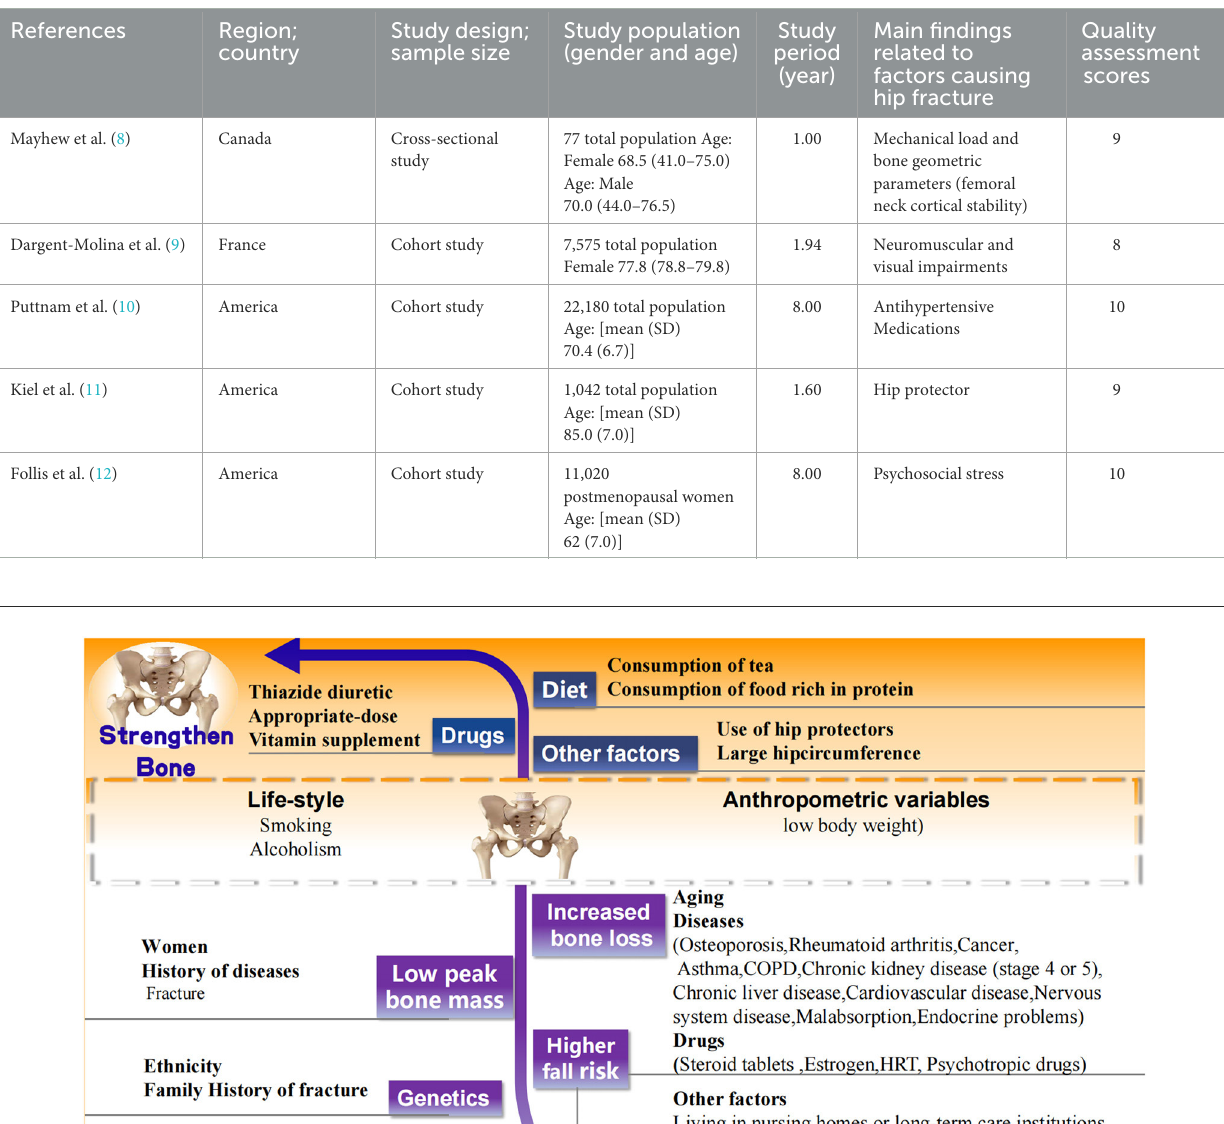
TABLE 2 Characteristics of included representative articles, summary of the main findings, and their quality assessment.